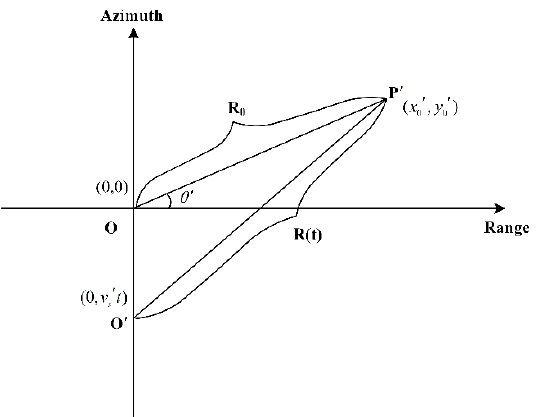
Figure 3. Geometric model of moving target based on relative speed.